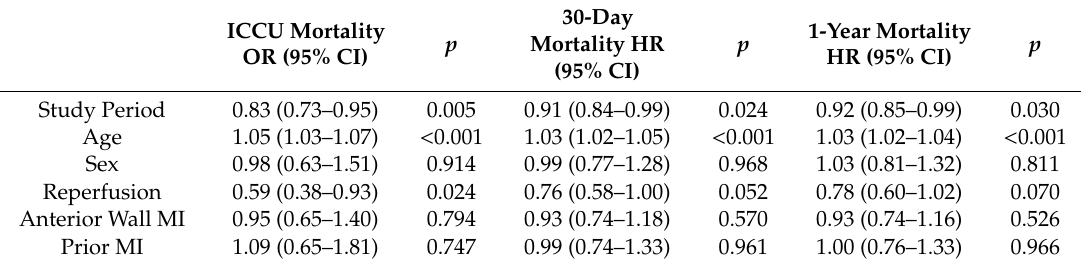
Figure 2. Thirty-day Cox regression multivariate analyses.